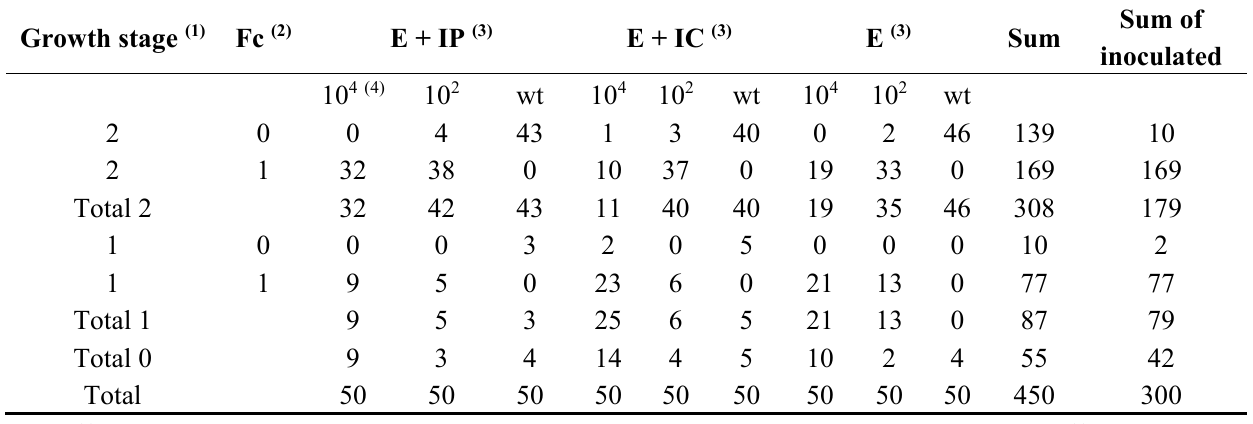
Table 1. Number of Pinus radiata ( P. radiata ) germlings in each category of growth stage at 48 dpi, with presence or absence of Fusarium circinatum (F. circinatum) mycelia for each inoculation method and dose applied to surface-disinfested seeds.